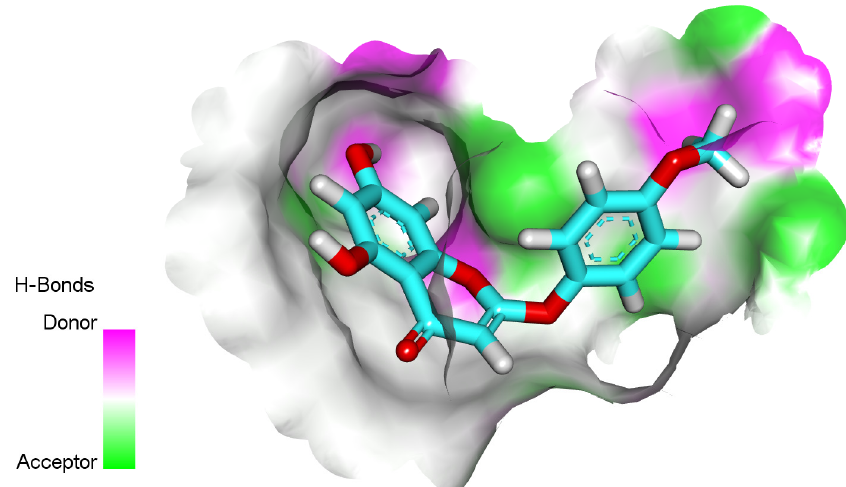
Figure 8. ( A ) 3D, ( B) 2D and ( C ) Surface mapping of 6-demethoxy-4`-O-capillarsine ( 1 ) inside the active site of PLP.